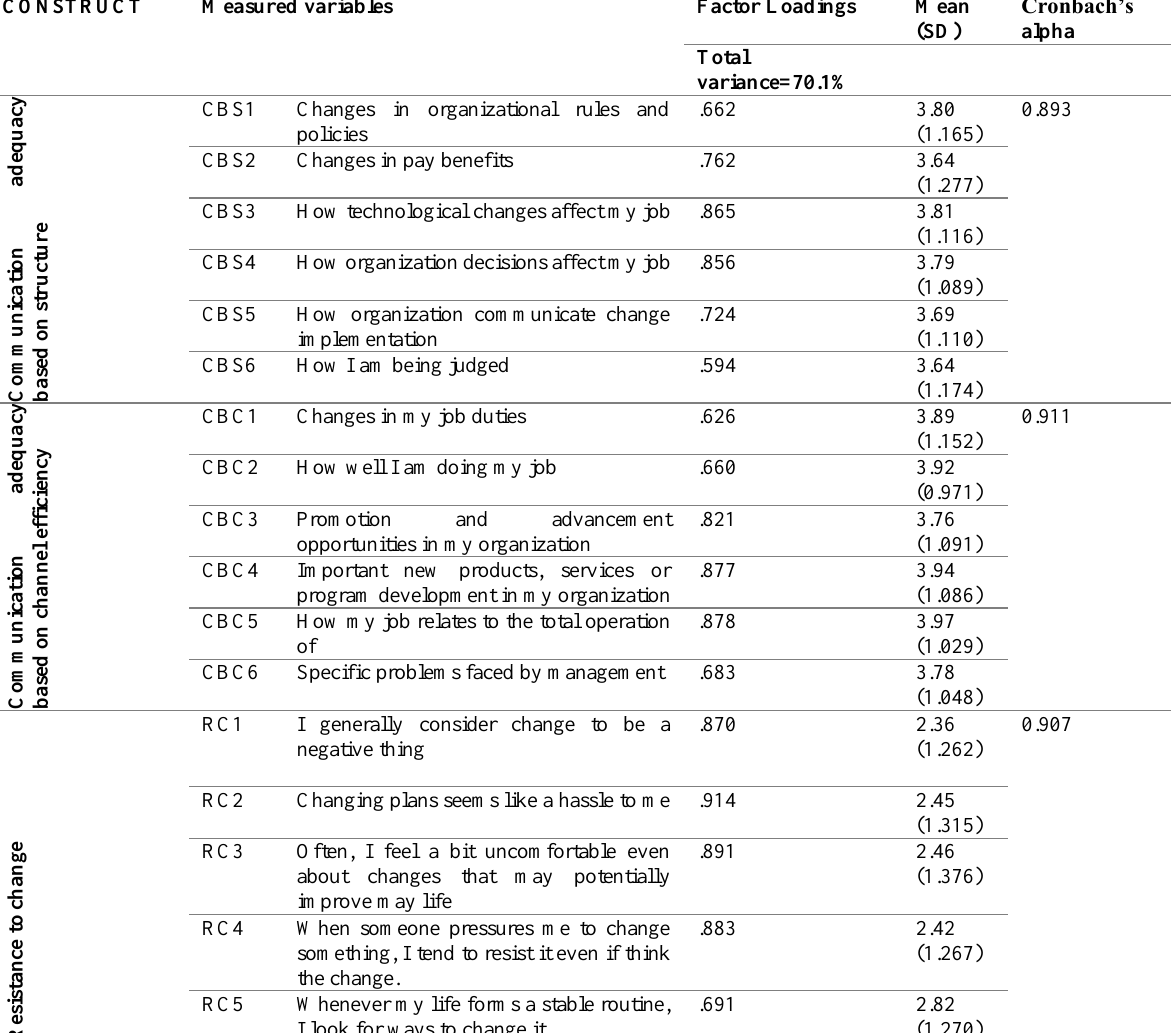
Table 2: Scale reliability and constructs validity of